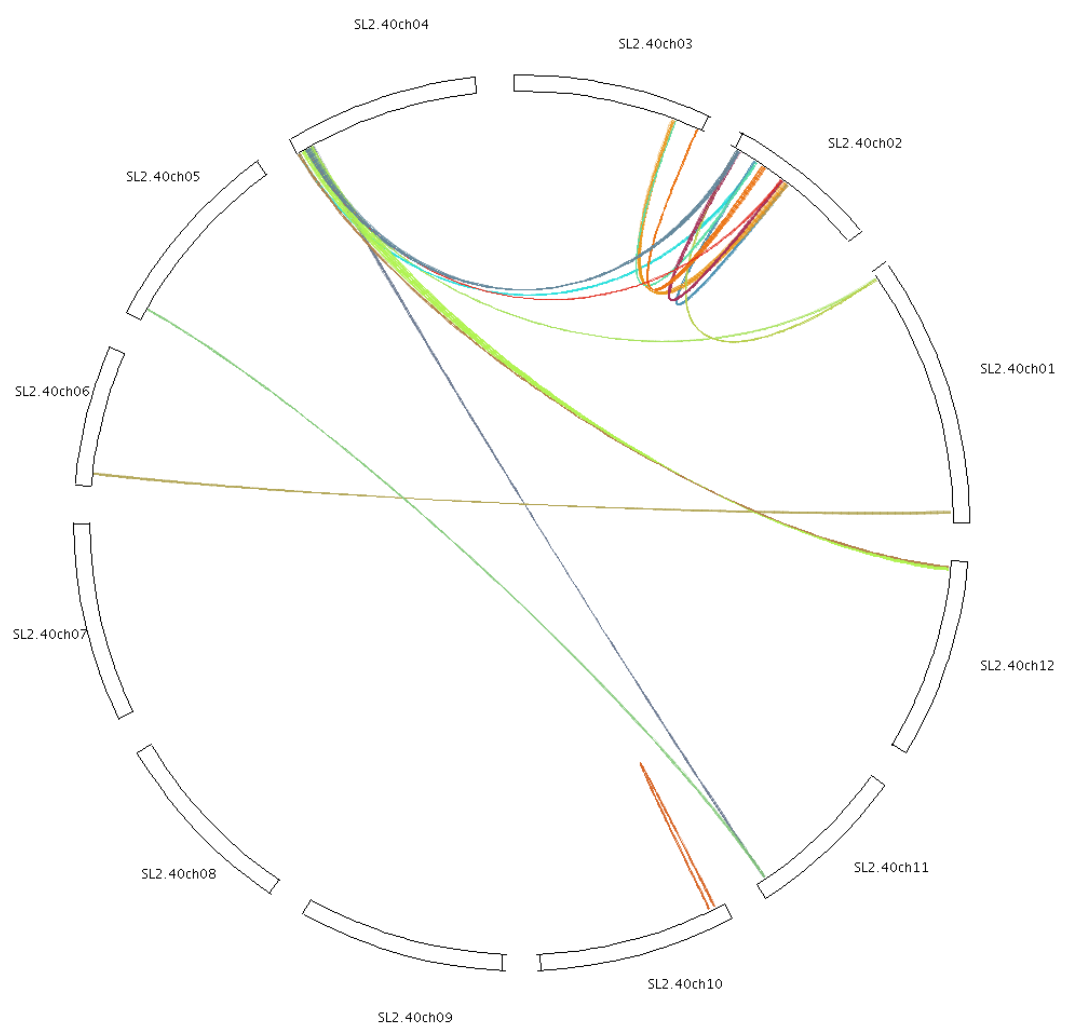
Figure 6. Depiction of segmentally duplicated cyclins on 12 tomato